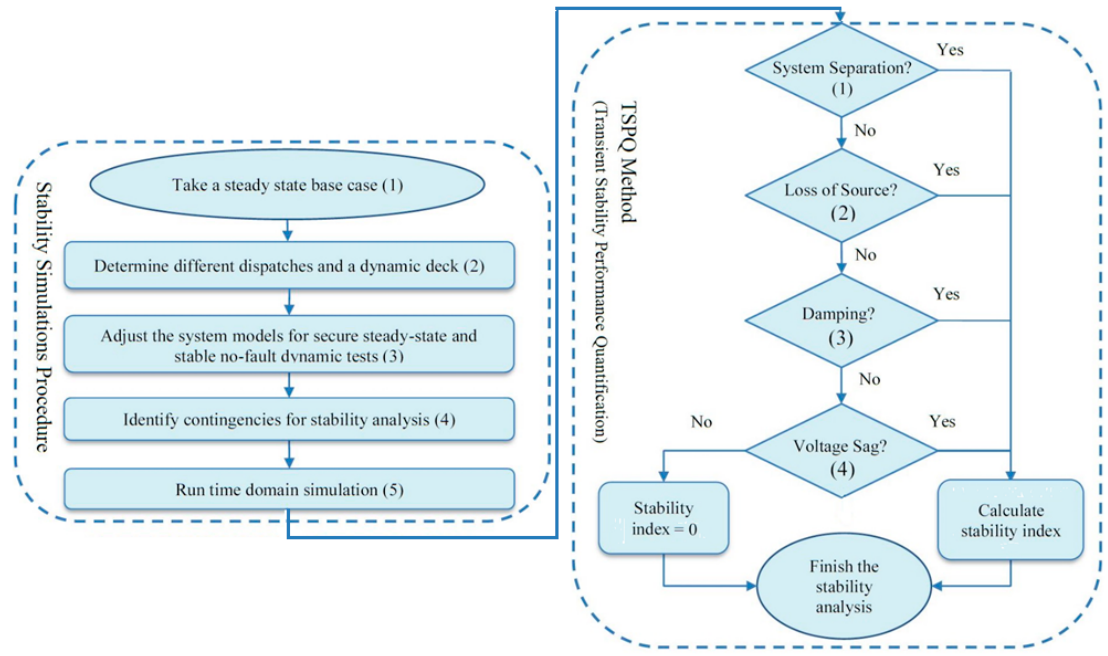
Figure 1. Proposed transient stability analysis procedure.